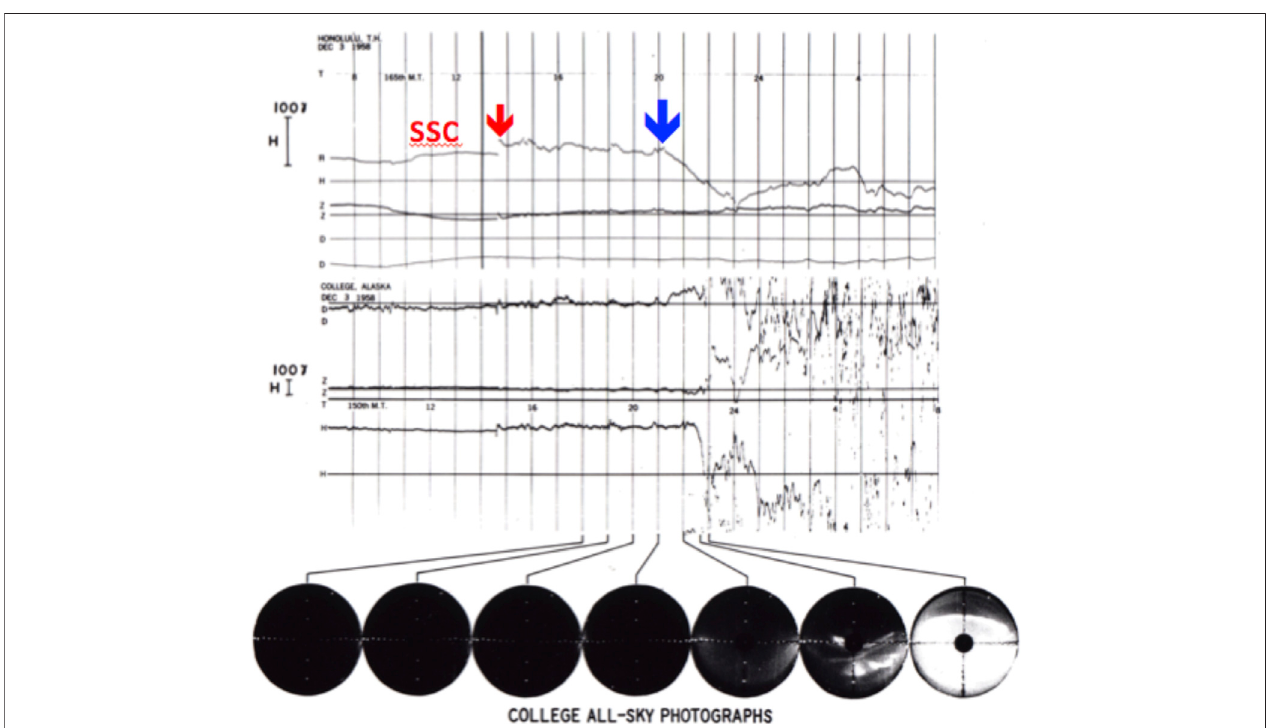
FIGURE2| Anexampleofthesimultaneousoccurrenceofthemainphase(Honolulumagnetogram),polarmagneticdisturbances[Fairbanks(College)]andauroral activities[all-sky images at Fairbanks (College)]. Itshows not only the longdelay oftheoccurrence ofthe main phase after thessc, but also thesimultaneous occurrence of intense auroral and magnetic disturbances.